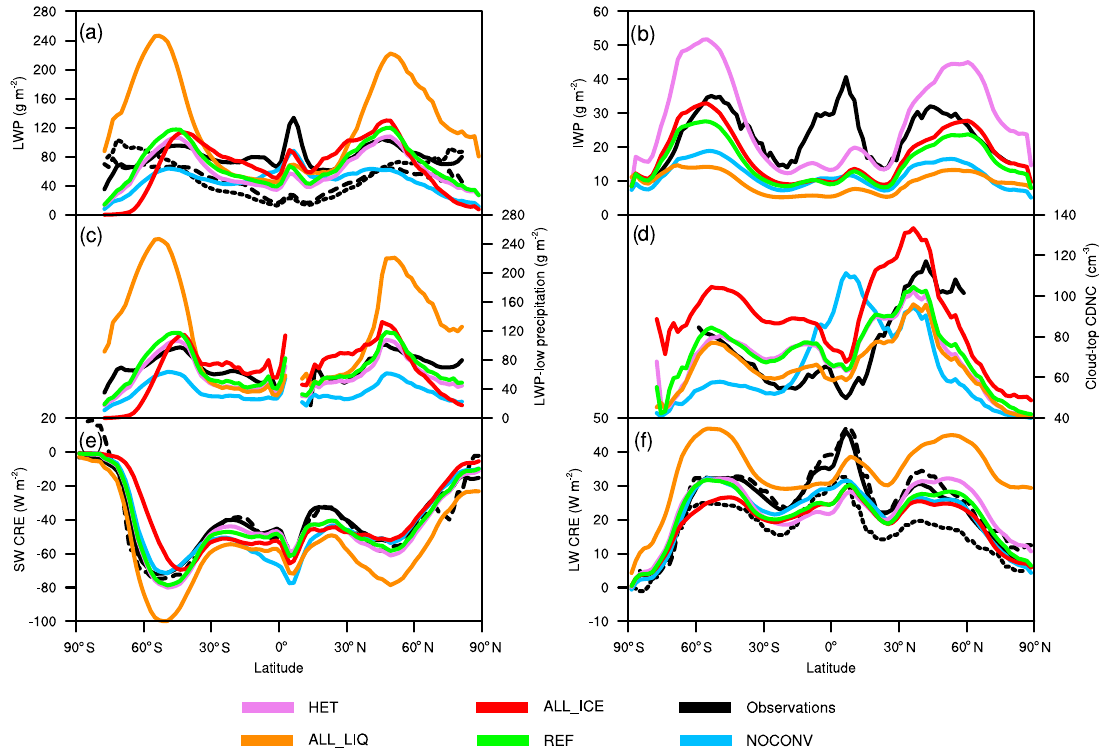
Figure 1. Annual zonal mean LWP oc (a) , IWP (b) , LWP oc , low_pr (c) , cloud-top CDNC of clouds between 268 and 300K (d) , SW CRE (e) , and LW CRE (f) from the atmosphere-only present-day simulations for the years 2003–2012 as described in Table 1 and observations of LWP from multiple satellite sensors for the years 1988–2016 by Elsaesser et al. (2018) (solid line), from MODIS-AQUA collection 6.1 for the years 2003–2012 (Platnick et al., 2015, 2017) (dotted line), from ATSR-2-AATSR for the years 2003–2012 (Stengel et al., 2017a) (dashed line), CloudSat + CALIPSO satellite observations of IWP for the years 2006–2010 from Li et al. (2012), low-precipitating oceanic LWP from Elsaesser et al. (2018) for the years 2003–2012, oceanic cloud-top CDNC for the years 2003–2015 from Bennartz and Rausch (2017), SW and LW CRE. The solid SW and LW CRE lines are from CERES 2003–2012 (Loeb et al., 2009, 2018), the dashed ones from ERBE for the years 1985–1989, and the dotted ones for LW CRE from TOVS satellite data for the years 1985–1993 (Susskind et al.,